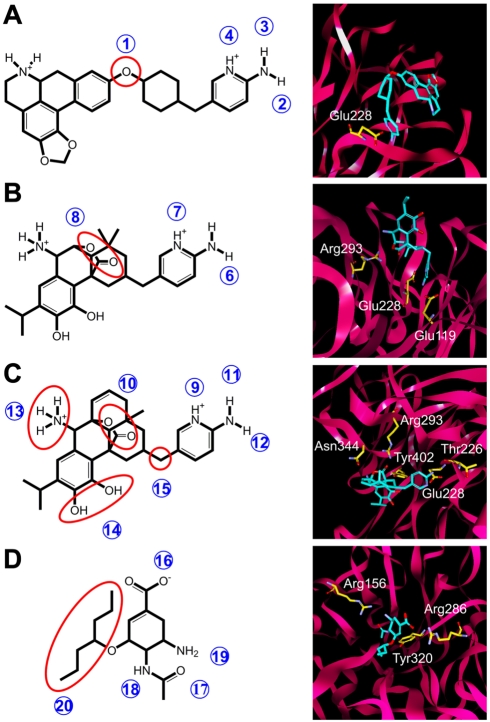
Important locations for ligand-N1 stability (left) and relative spatial arrangements (right) within the N1 protein binding site.(A) Xylopine_2, (B) Rosmaricine_14, (C) Rosmaricine_15, and (D) Tamiflu®. Ligands are presented in cyan, amino acids in yellow, and hydrogen bond formations in white dashed lines.